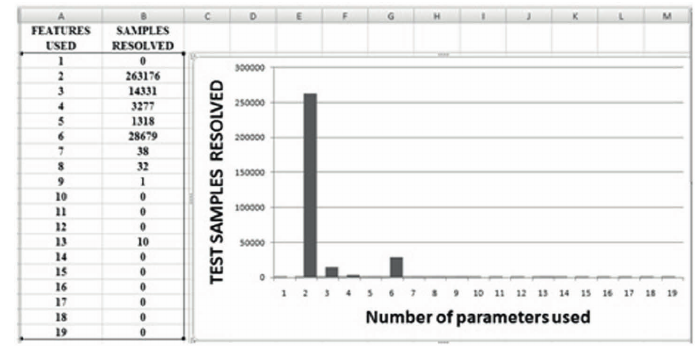
Figure 3. Number of parameters used vs number of test cases